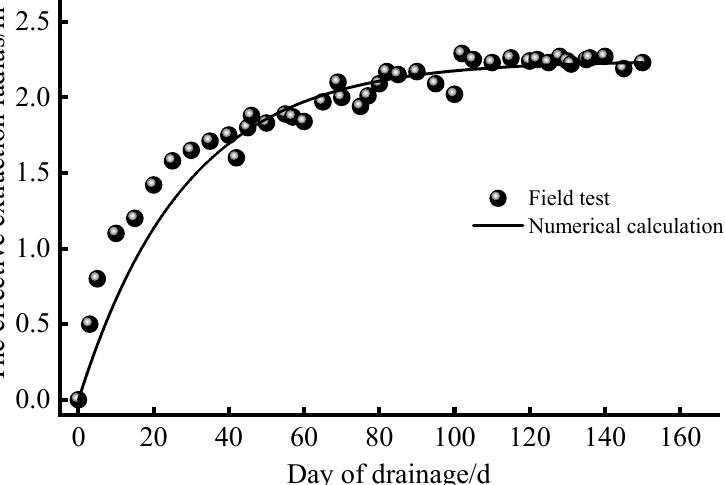
Figure 10. Comparison of the effective extraction radius between a numerical calculation and field test.